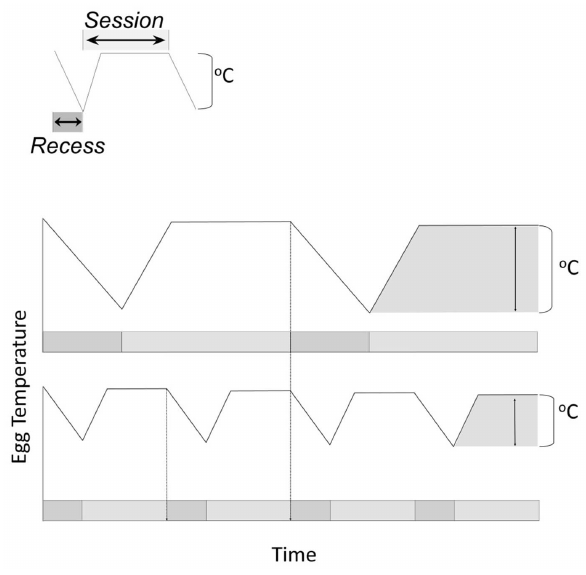
Figure 3. Schematic of egg temperatures resulting from off- bouts/on-bout combinations. Increased frequency of off-bouts from the nest, coupled with a decrease in time on the nest per incubation on-bout, can elevate minimum egg temperature and reduce temper- ature variations. The key to this counterintuitive result is that incubation on-bouts are not decreased to the same extent as incubation off-bouts. When on-bouts are considered cumulative over the course of a day, nest attentiveness increases in spite of the decreased time on the nest during individual incubation on-bouts. This pattern has the advantage of decreasing temperature variation while simultaneously limiting low egg temperatures.